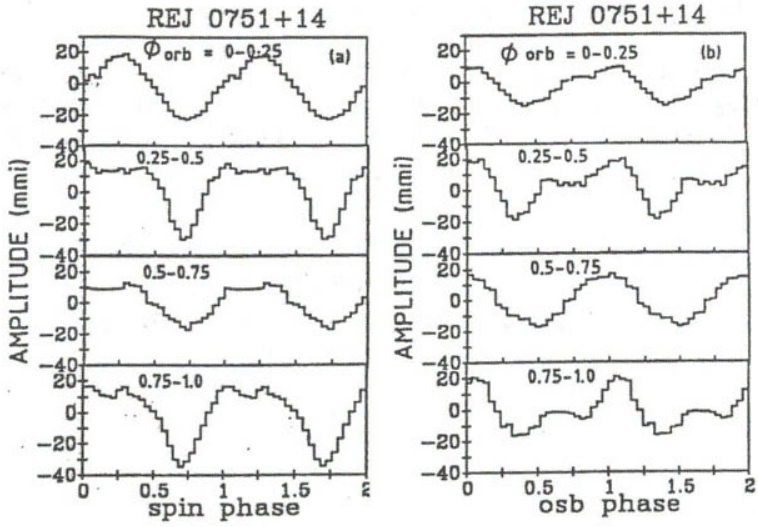
Fig. 2. Spin and orbital side-band pulse profiles as a function of or- bital phase. In the case of orbital side-band, the second and fourth panels from the top indicate the emergence of a double peaked pulse